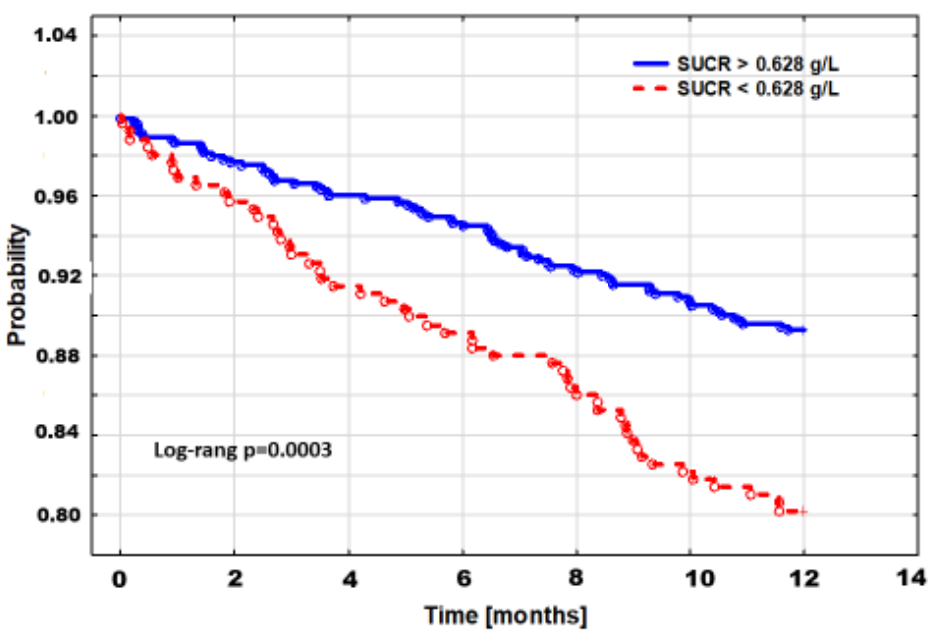
Figure 2. Kaplan–Meier cumulative survival curves for low and high Figure 2. Kaplan – Meier cumulative survival curves for low and high SUCR.